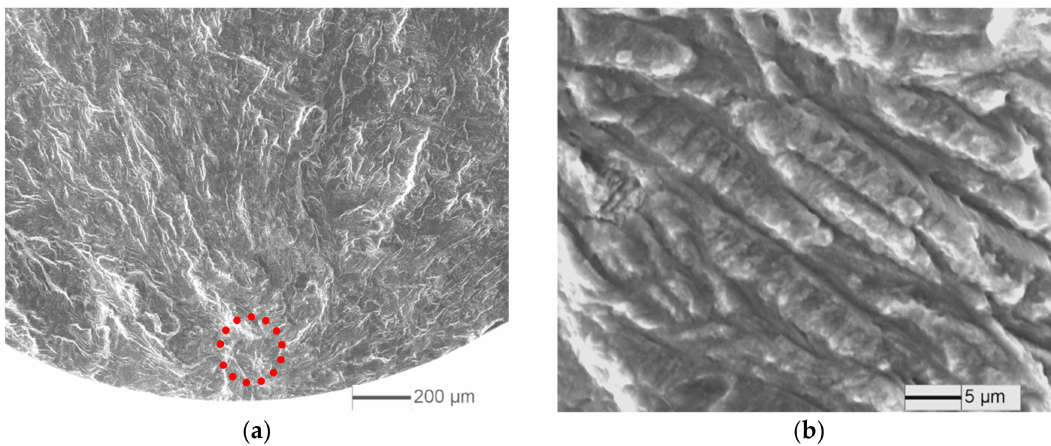
Figure 7. Fatigue fracture surface of TC21 titanium alloy at σ = 460 MPa and N = 1.59 × 10 7 cycles: ( a ) fatigue crack initiation site (remarked by red line), and ( b ) high magnification morphology of the crack initiation site.